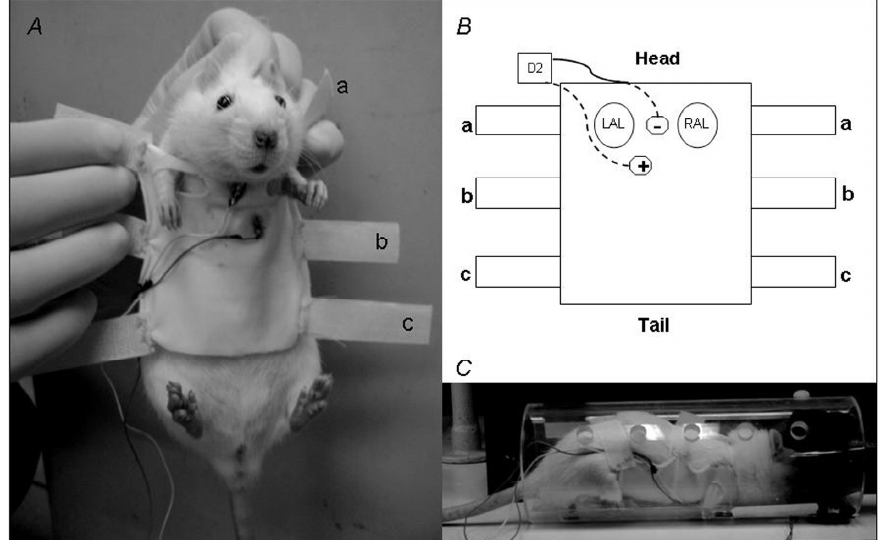
Fig. 1 – ECG acquisition method: A – jacket placement on the rat. B – schematic diagram of the inner face of the jacket, illustrating negative and positive electrodes positions. LAL – left anterior limb; RAL – right anterior limb. C – restrained animal in rest during signal